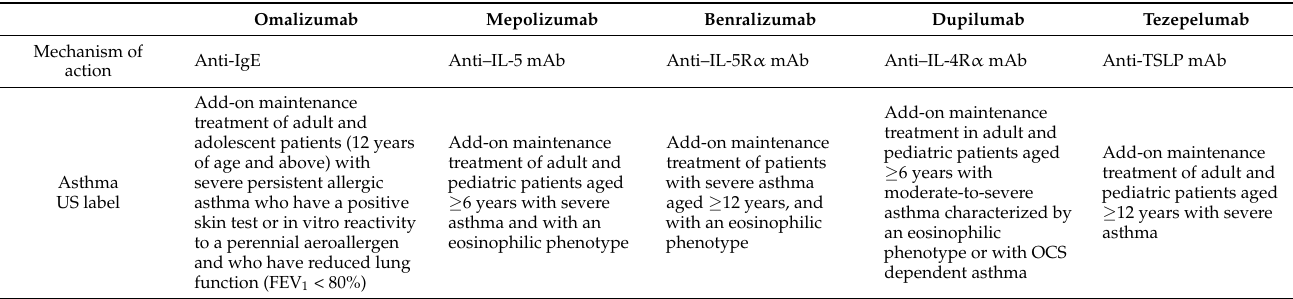
Table 1. Overview of prescription information and